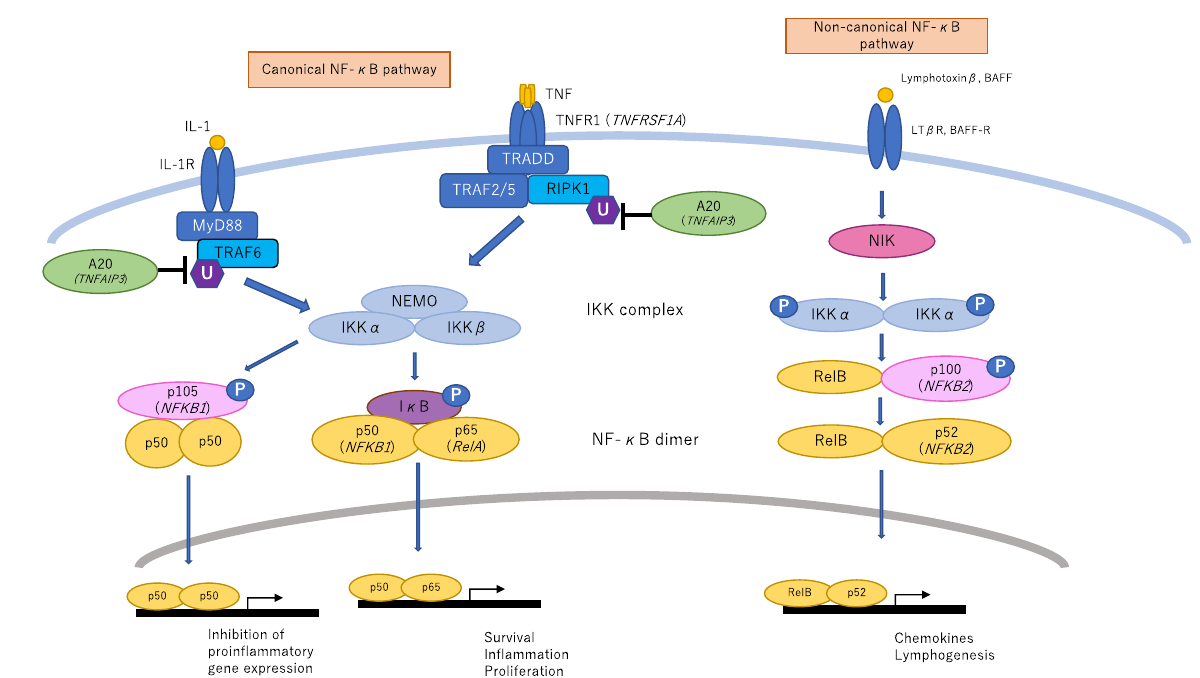
Figure 1. NF- κ B signaling pathway and the genes associated with BD-like phenotypes. In the canonical pathway, when signals such as TNF- α and IL-1 β are recognized by cytokine receptors, RIPK1 (Receptor-interacting serine/threonine-protein kinase 1) and tumor necrosis factor receptor-associated factor 6 (TRAF6) are ubiquitinated and the I κ B kinase (IKK) complex is activated. Activation of the IKK complex leads to I κ B phosphorylation and NF- κ B (p50/p65) activation. Activated NF- κ B is translocated into the nucleus where it activates targeted gene expression. P50 homodimers curb inflammatory reactions. A20 acts on ubiquitination and suppressively regulates this pathway. In particular, upon TNF receptor stimulation, A20 removes K63-linked polyubiquitin chains, thereby preventing the interaction of RIPK1 with NEMO, and subsequently adds K48-linked polyubiquitin chains to RIPK1, targeting it for proteasomal degradation. Furthermore, upon IL-1 receptor binding, A20 removes K63-linked polyubiquitin chains from TRAF6. In the non-canonical pathway, when ligands such as lymphotoxin- β and BAFF (B cell-activating factor belonging to the TNF family) bind to the receptor, NF- κ B inducing kinase (NIK) is activated. Phosphorylation of IKK complex by activated NIK leads to p100 (I κ B domain) phosphorylation and NF-κB (p52/RelB) activation.